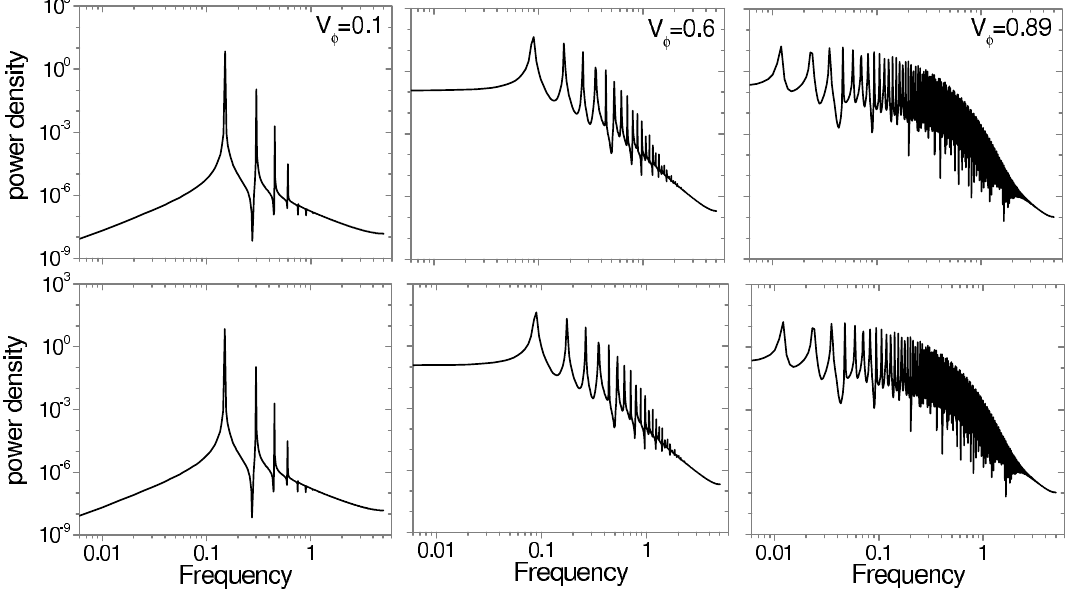
Fig. 3. FFT spectra of both the forward-propagating E i (upper panels) and the backward-propagating one (lower panels): (1) sinusoidal solitons with V φ 0 = 0 . 1 (left-column panels); (2) sawtooth solitons with V φ 0 = 0 . 6 (middle-column panels); (3) bipolar solitons with V φ 0 = 0 . 89 (right-column panels).